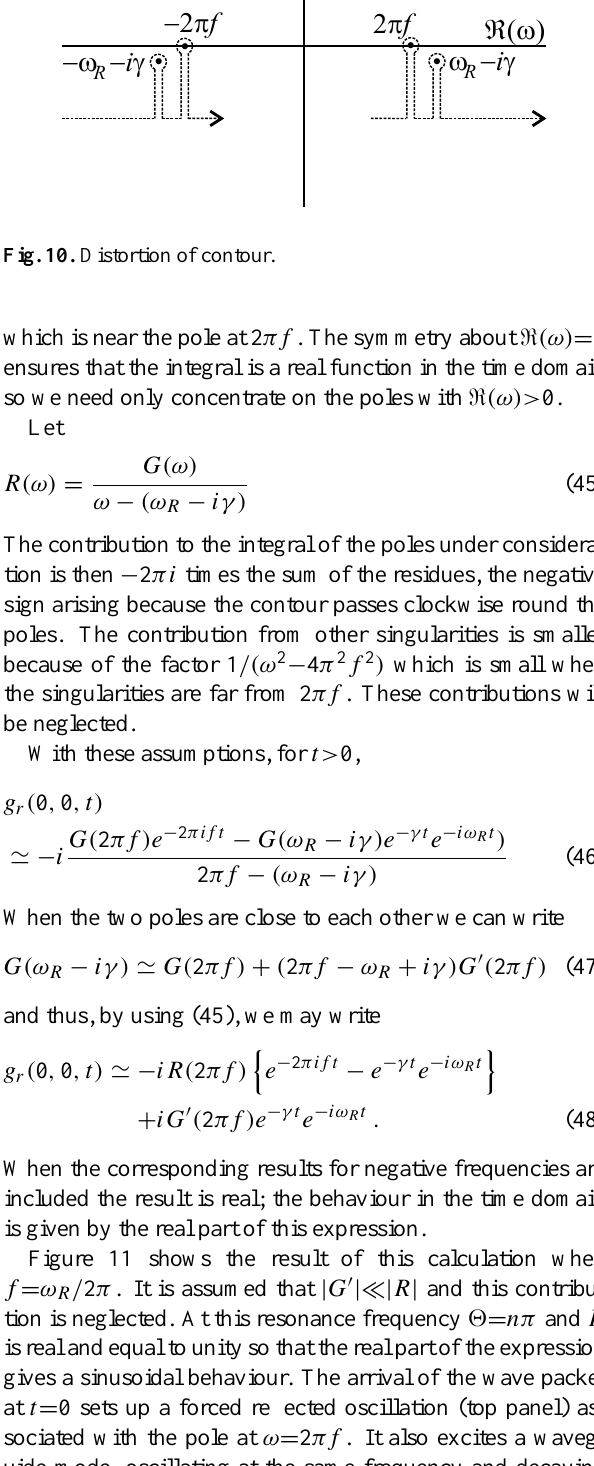
Fig. 10. Distortion of contour.